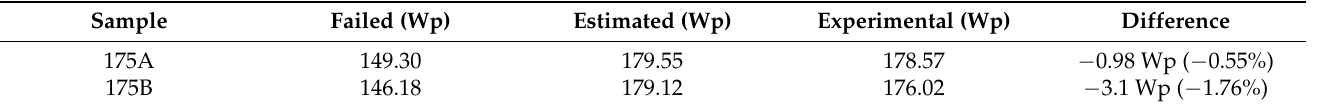
Table 5. The difference between the estimated and the experimental value of